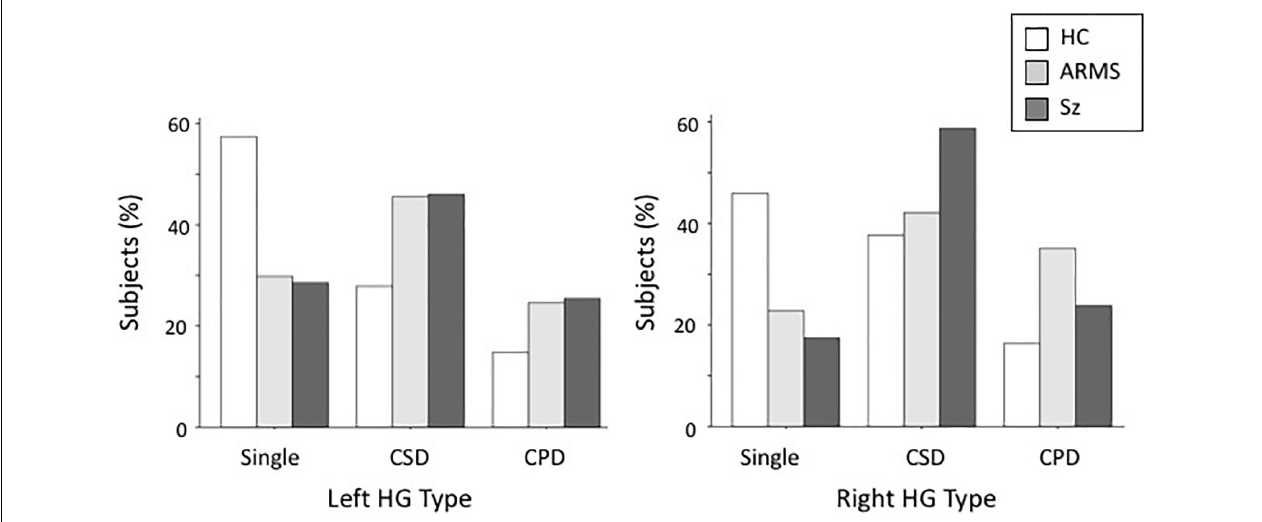
FIGURE 2 | Distribution of Heschl’s gyrus (HG) gyrification patterns in schizophrenia (SZ), at-risk mental state (ARMS), and healthy comparison (HC) groups. CPD, complete posterior duplication; CSD, common stem